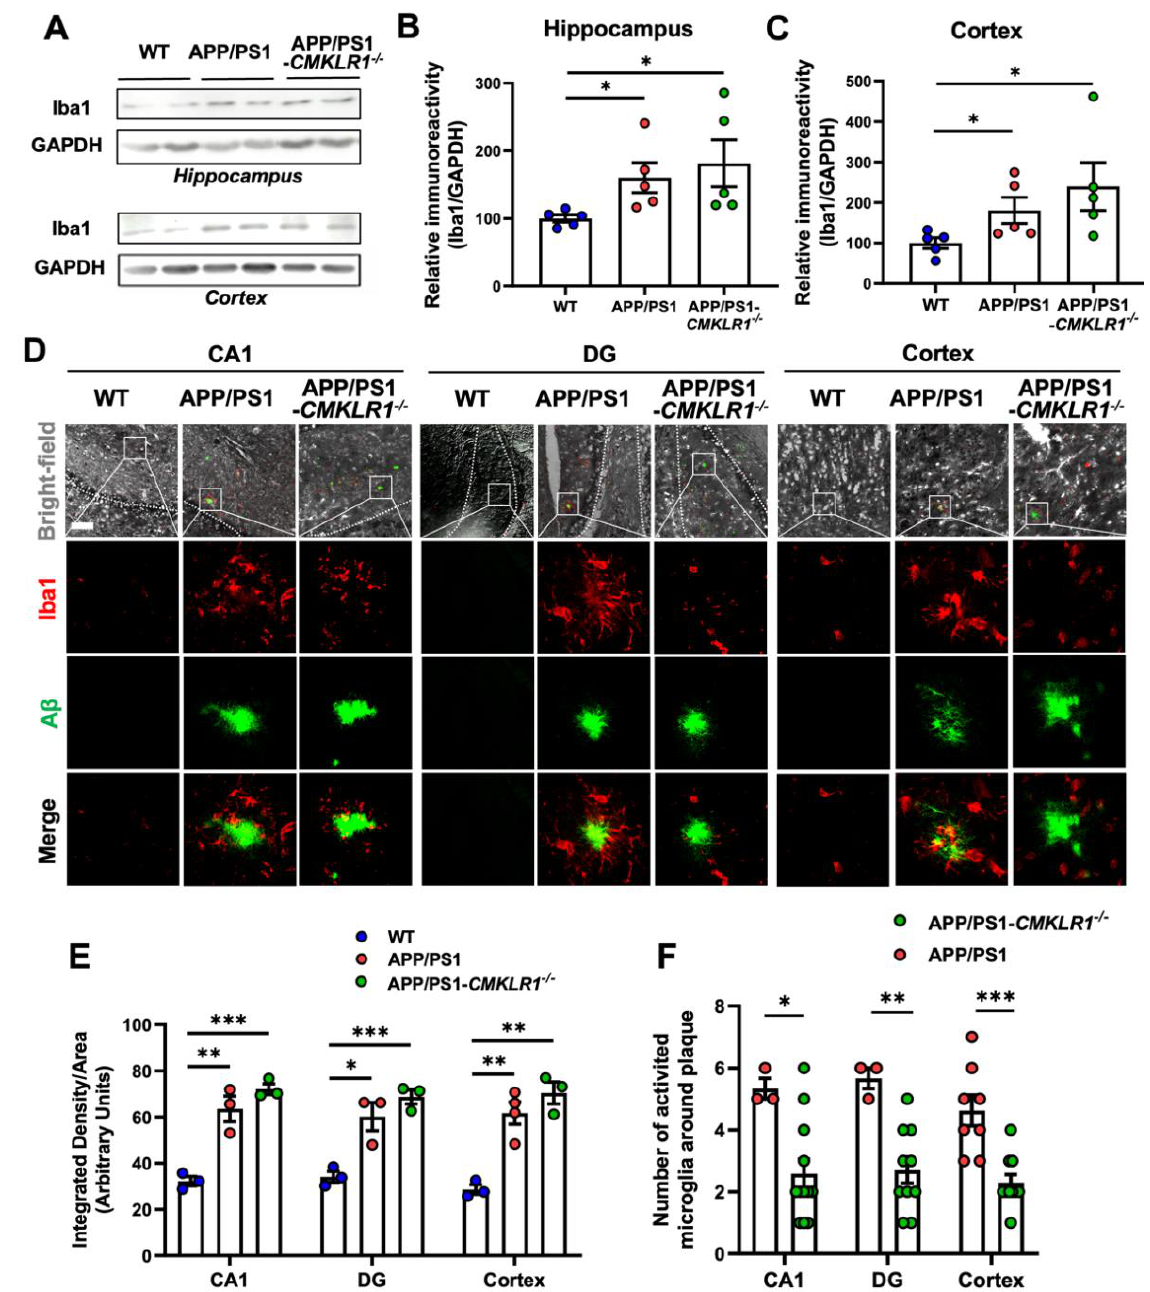
Figure 1. CMKLR1 deficiency reduces the number of activated microglia around Aβ plaques in brain of APP/PS1 transgenic mice. ( A ) Representative Western blot showing the expression of Iba1 in the hippocampus and cortex in 9-month-old WT, APP/PS1, and APP/PS1- CMKLR1 −/− mice. ( B , C ) Quantification of immunoreactivity of the blots, normalized against GAPDH. ( D ) Serial sections of 9-month-old WT, APP/PS1, and APP/PS1- CMKLR1 −/− mice brains were stained for Aβ deposits (green fluorescence) and microglia (red fluorescence) as described in the “Materials and methods” section. The scale bar in the upper left panel is 100 μm. Selected areas are enlarged by 25 times and shown as combined as well as individual fluorescence stains. Quantification of the fluorescence of microglia ( E ), and the number of microglia ( F ) around A β deposits was shown. The results are expressed as the mean ± SEM on each region by using at least 3 mice in each group. * p < 0.05, ** p < 0.01, *** p < 0.001.